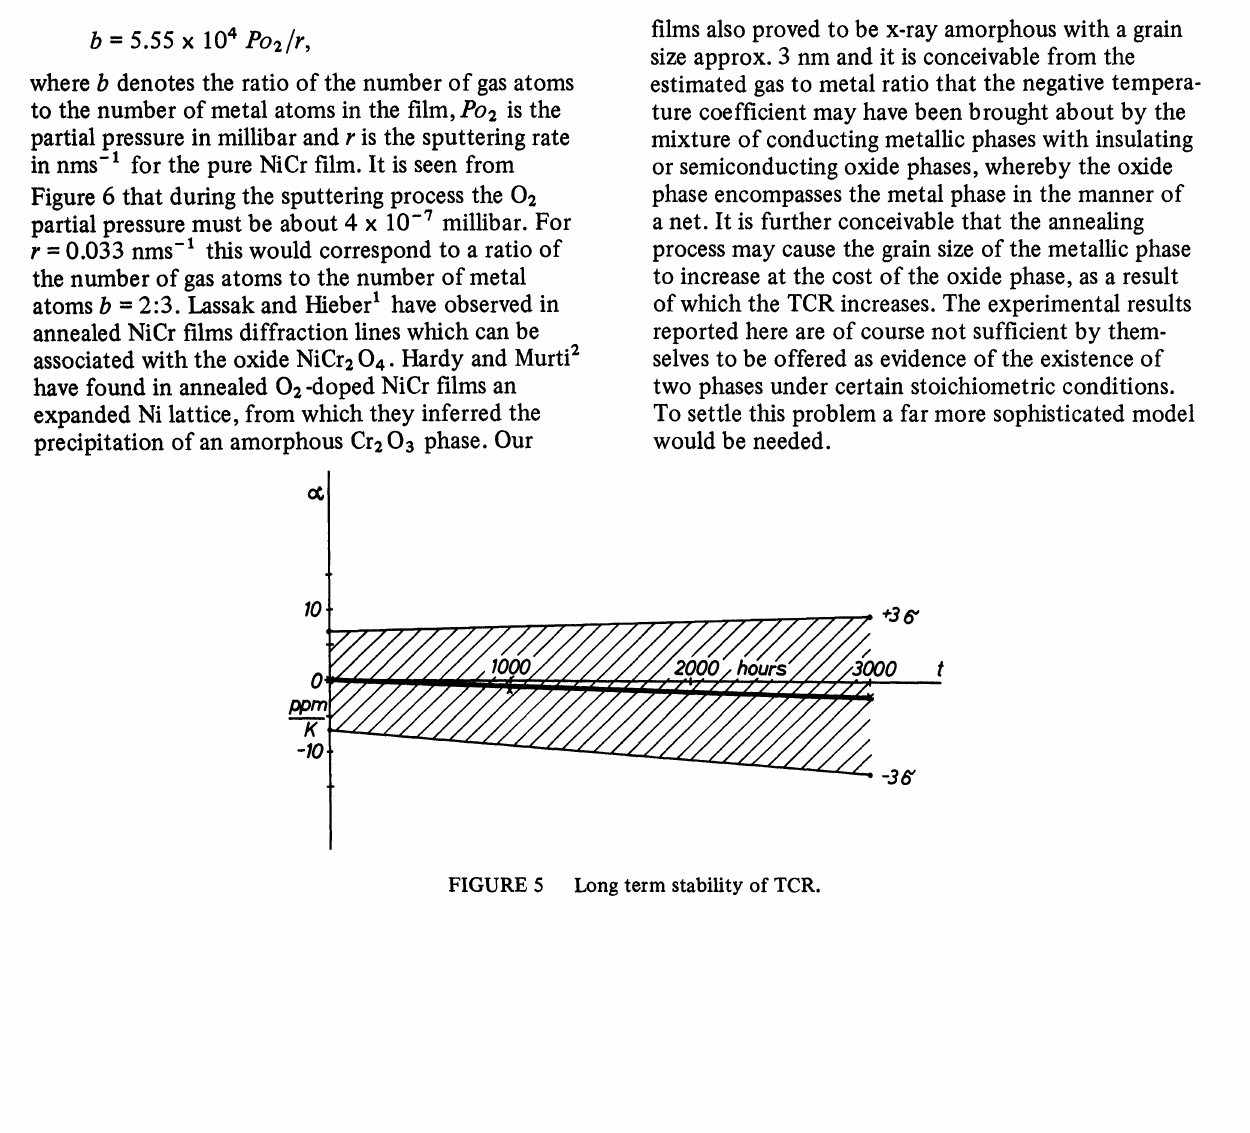
FIGURE 4 Long term stability of resistivity.